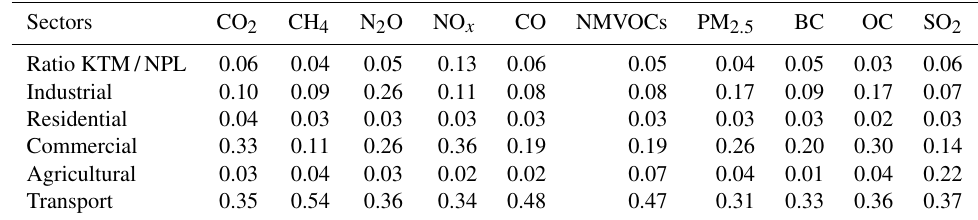
Table 4. Comparison of total and sectoral emission ratios for the Kathmandu Valley and Nepal for 2011. Sectors CO 2 CH 4 N 2 O NO x CO NMVOCs PM 2 . 5 BC OC SO 2 Ratio